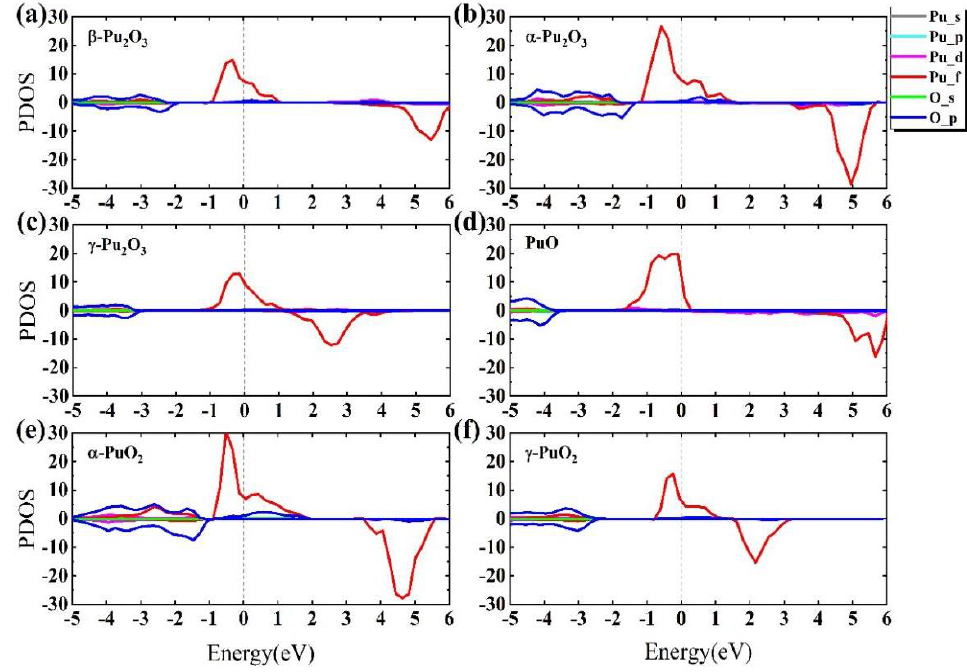
Figure 3. The electronic projected density of states (PDOS) of ( a ) β -Pu 2 O 3 , ( b ) α -Pu 2 O 3 , ( c ) γ -Pu 2 O 3 , ( d ) PuO, ( e ) α -PuO 2 , ( f ) γ -PuO 2 .